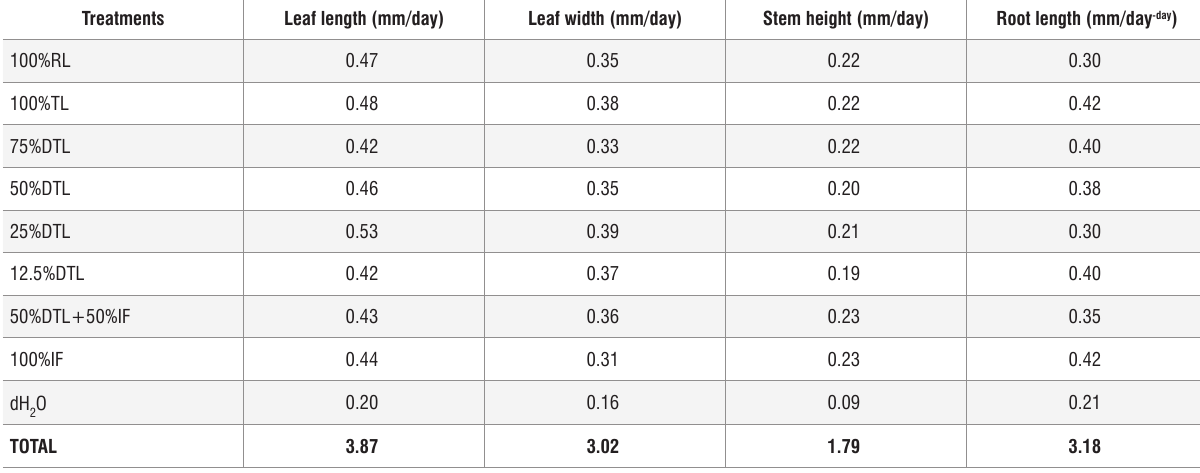
Table 5: Specific growth rate comparison for Brassica rapa L. at harvest after 56 days